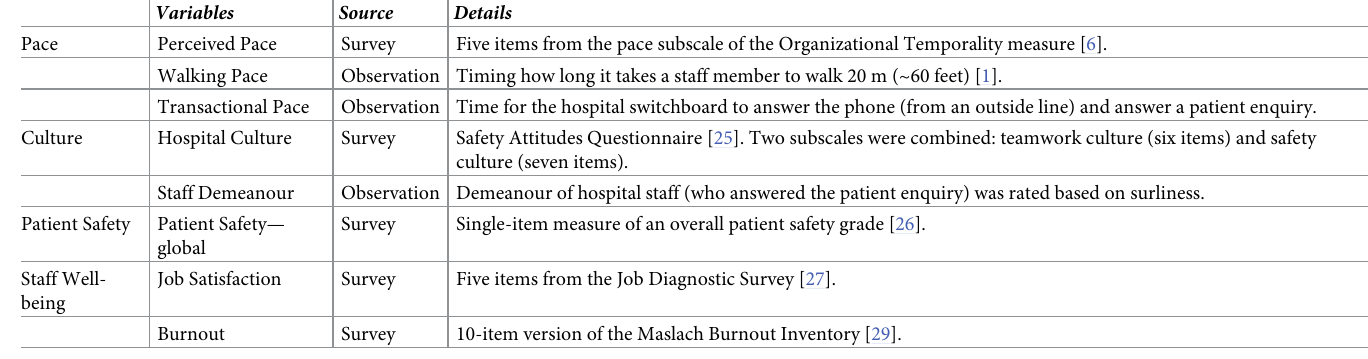
Table 1. Summary of study